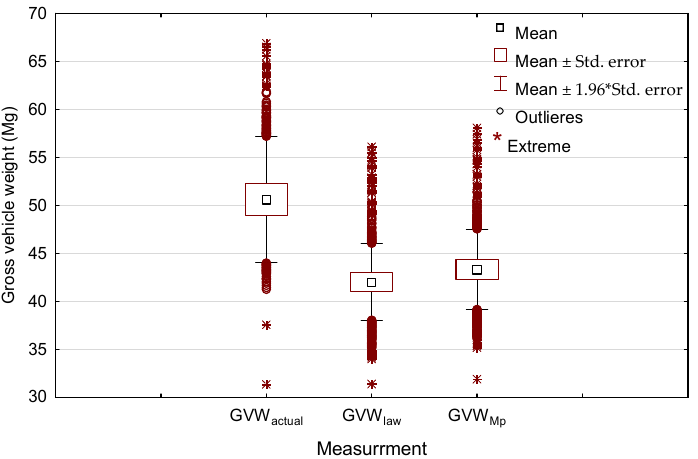
Figure 11. Comparison of the real total gross vehicle weight of transport sets for large-sized wood loads with that determined by legislation and accurate measurement by laser scanning.